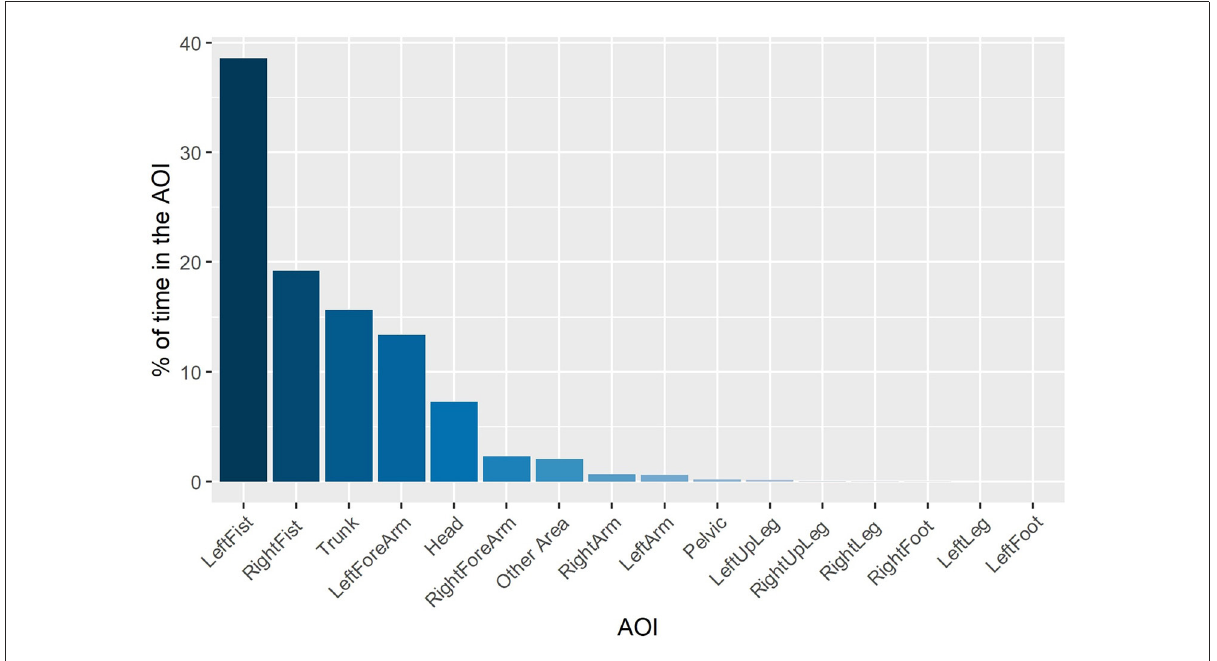
FIGURE4 Percentage of time that gaze was located in the